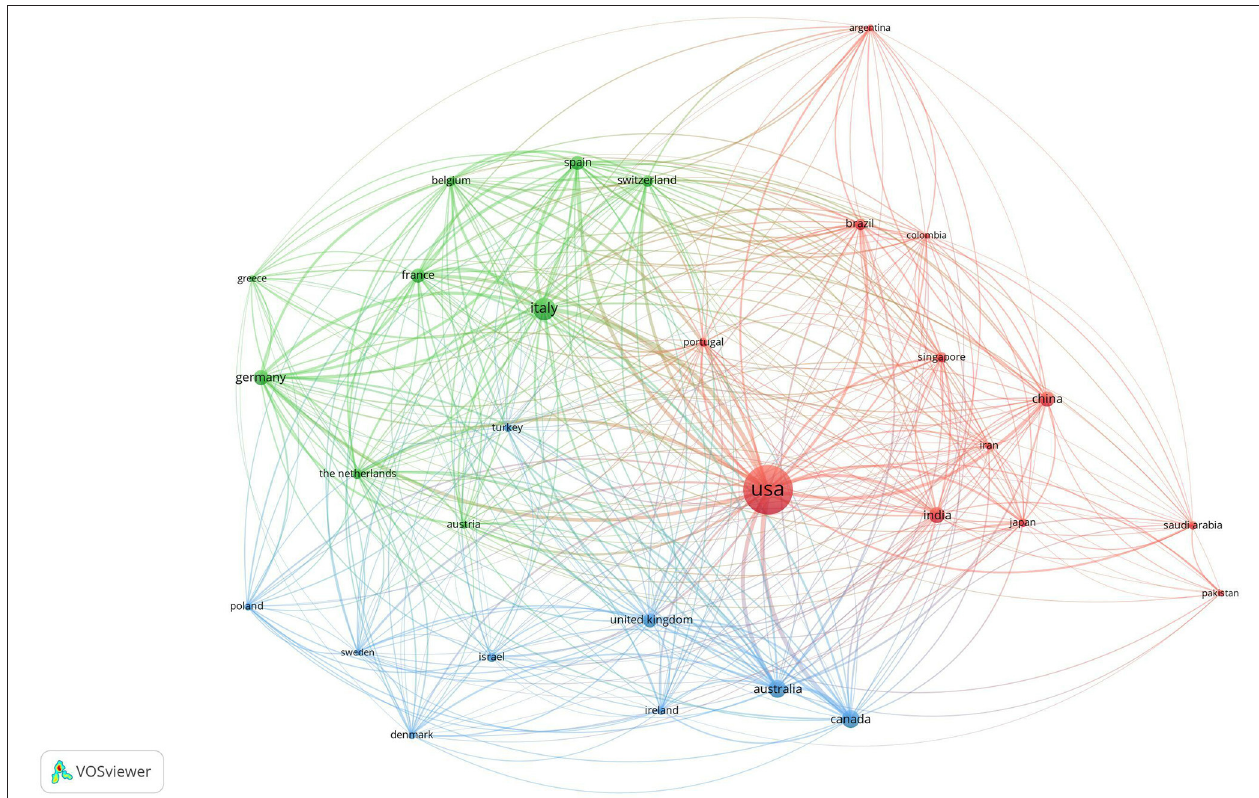
FIGURE 2 | The cooperation of countries/regions in telemedicine at